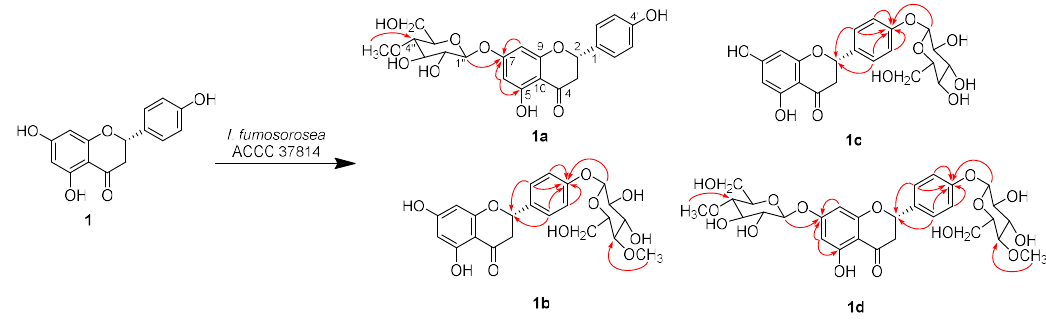
Molecules 2019 , 24 , x 4 of 13 Figure 3. Product profiles of flavonoids 1 – 4 biotransformed in the I. fumosorosea ACCC 37814 cultures (reverse phase High Performance Liquid Chromatography (HPLC) traces recorded at 300 nm). HPLC traces of each standard substrate (colored in red) were used as references. 2.2. Structure